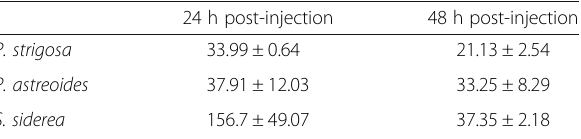
Table 1 Toxicity of the aqueous extracts to crickets expressed as LD 50 ( μ g protein/g) 24 h post-injection